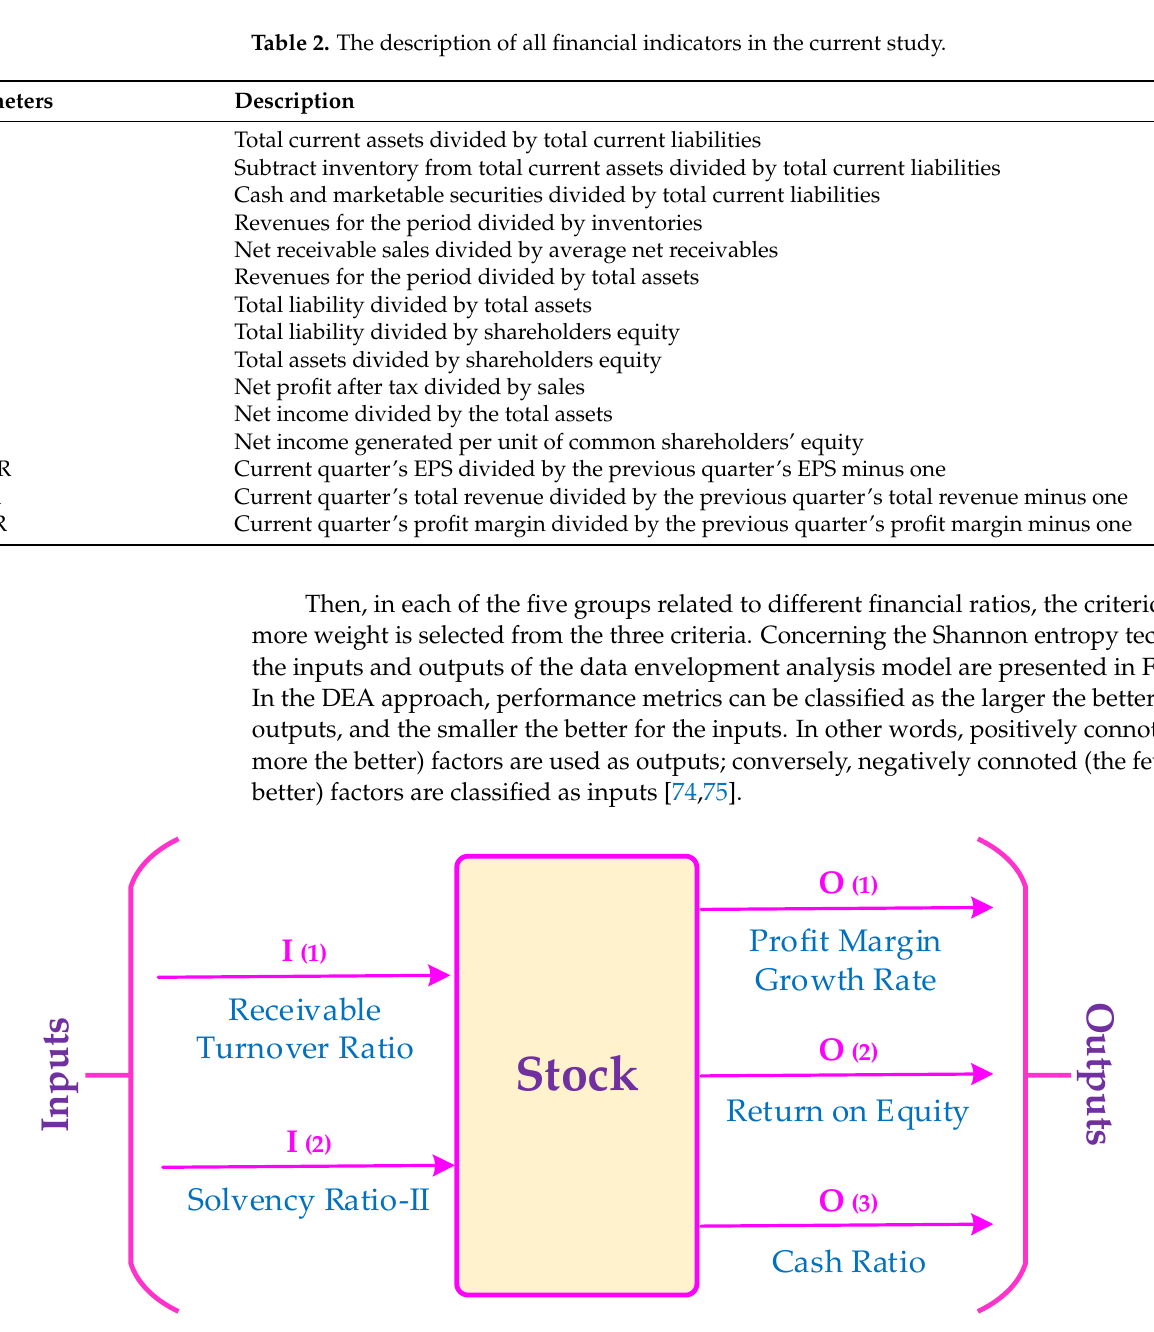
Table 3. Data set for 15 stocks from Tehran stock exchange. Stocks